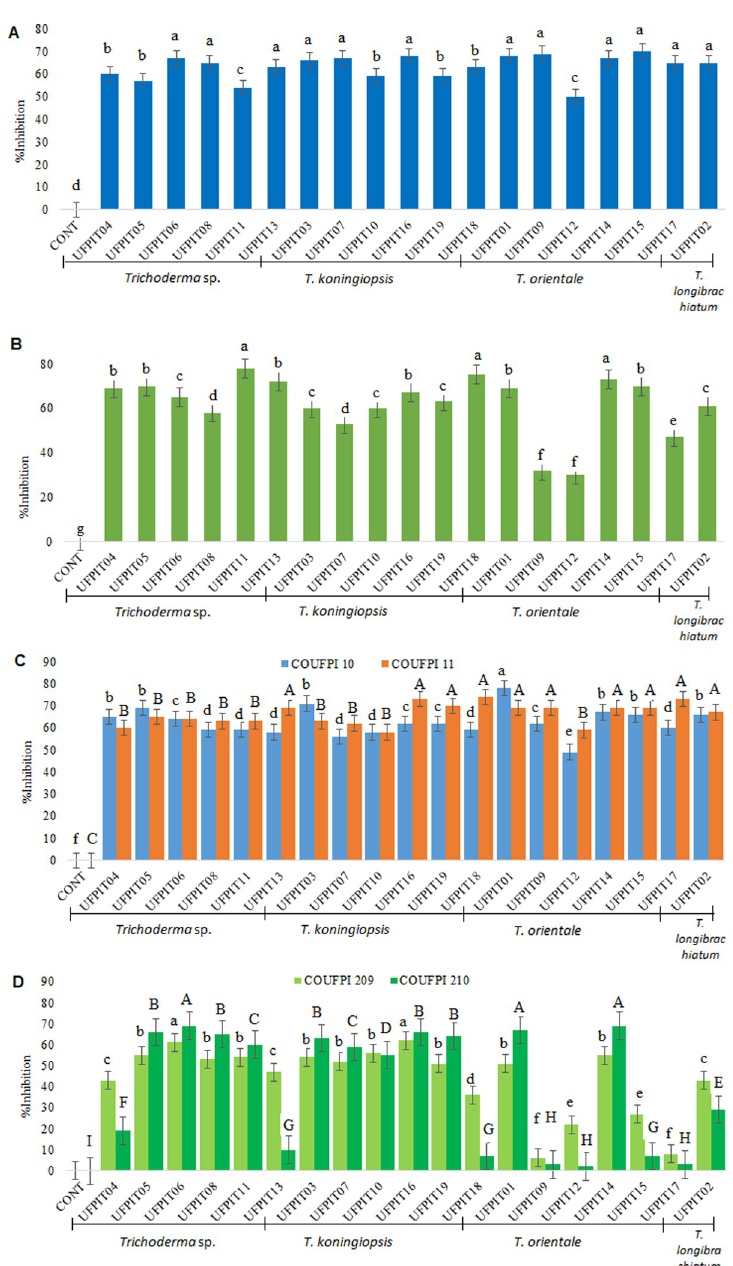
Fig 1. In vitro percent inhibition of Trichoderma spp. isolates against C . truncatum (A), L . theobromae (B), M . phaseolina COUFPI 10 and COUFPI 11 (C), and S . delphinii COUFPI 209 and COUFPI 249 (D). Averages followed by the same lowercase or capital letter are not significantly different by the Scott–Knott test at the 5% confidence level. The variation coefficients (CVs) were 4.67% for L . theobromae , 4.55% for M . phaseolina COUFPI 10, 5.96% for M . phaseolina COUFPI 11, 8.37% for S . delphinii COUFPI 209 and 6.02% for S . delphinii COUFPI